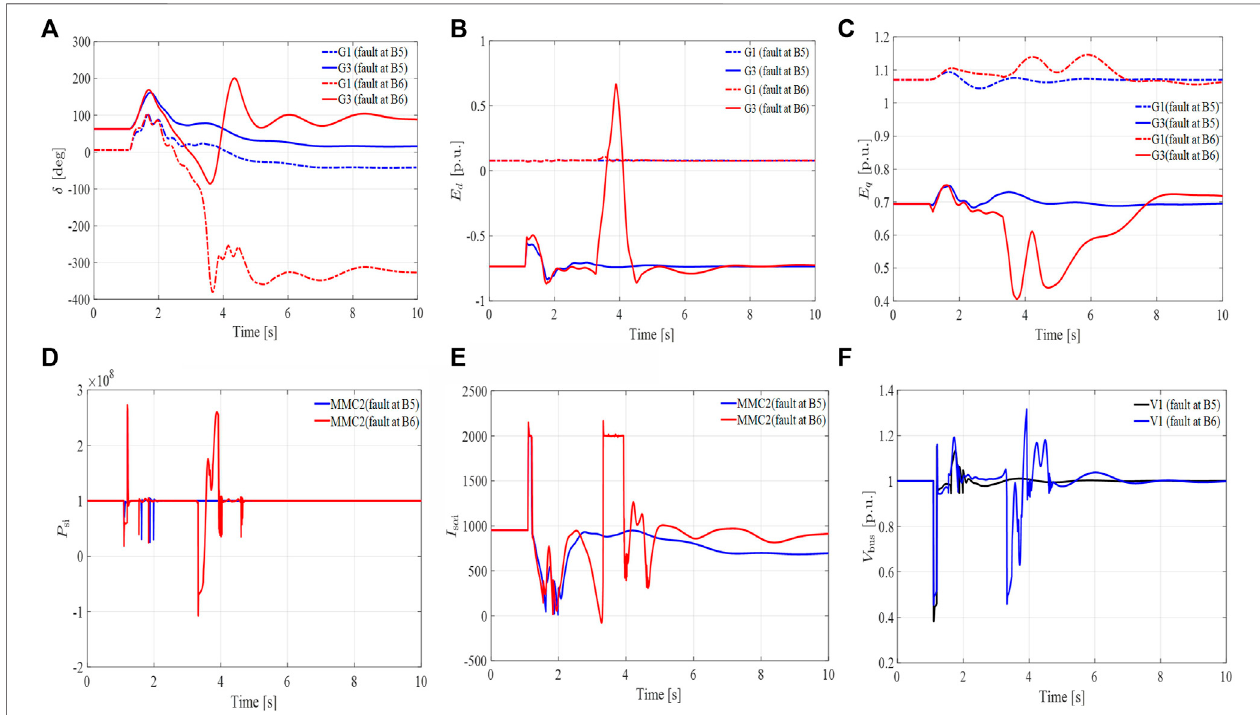
FIGURE 9 | Dynamic responses of the generator and the MMC – MTDC in an original control method. (A) The rotor angles of generator 1,3 in degrees. (B) d-axis componentofthevoltage1,3behindtransientreactanceinp.u. (C) q-axiscomponentofthevoltage1,3behindtransientreactanceinp.u. (D) ActivepowerofMMC2. (E) α component of the MMC2 output-current. (F) Voltage of bus 1 in main grid.